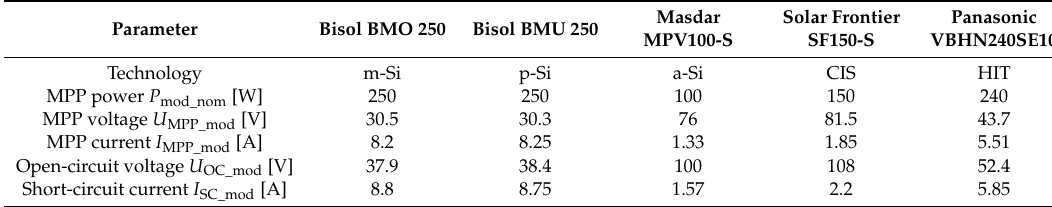
Table 1. Technical characteristics of PV modules under study [27–31].